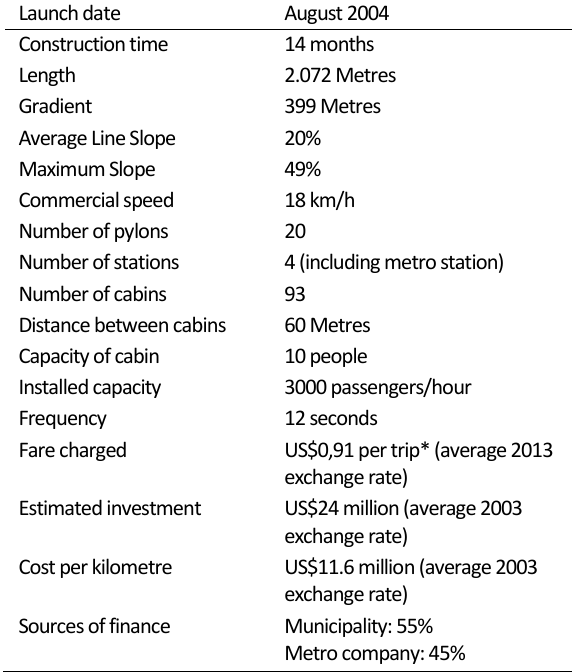
Table 2. Metrocable Line K: Basic